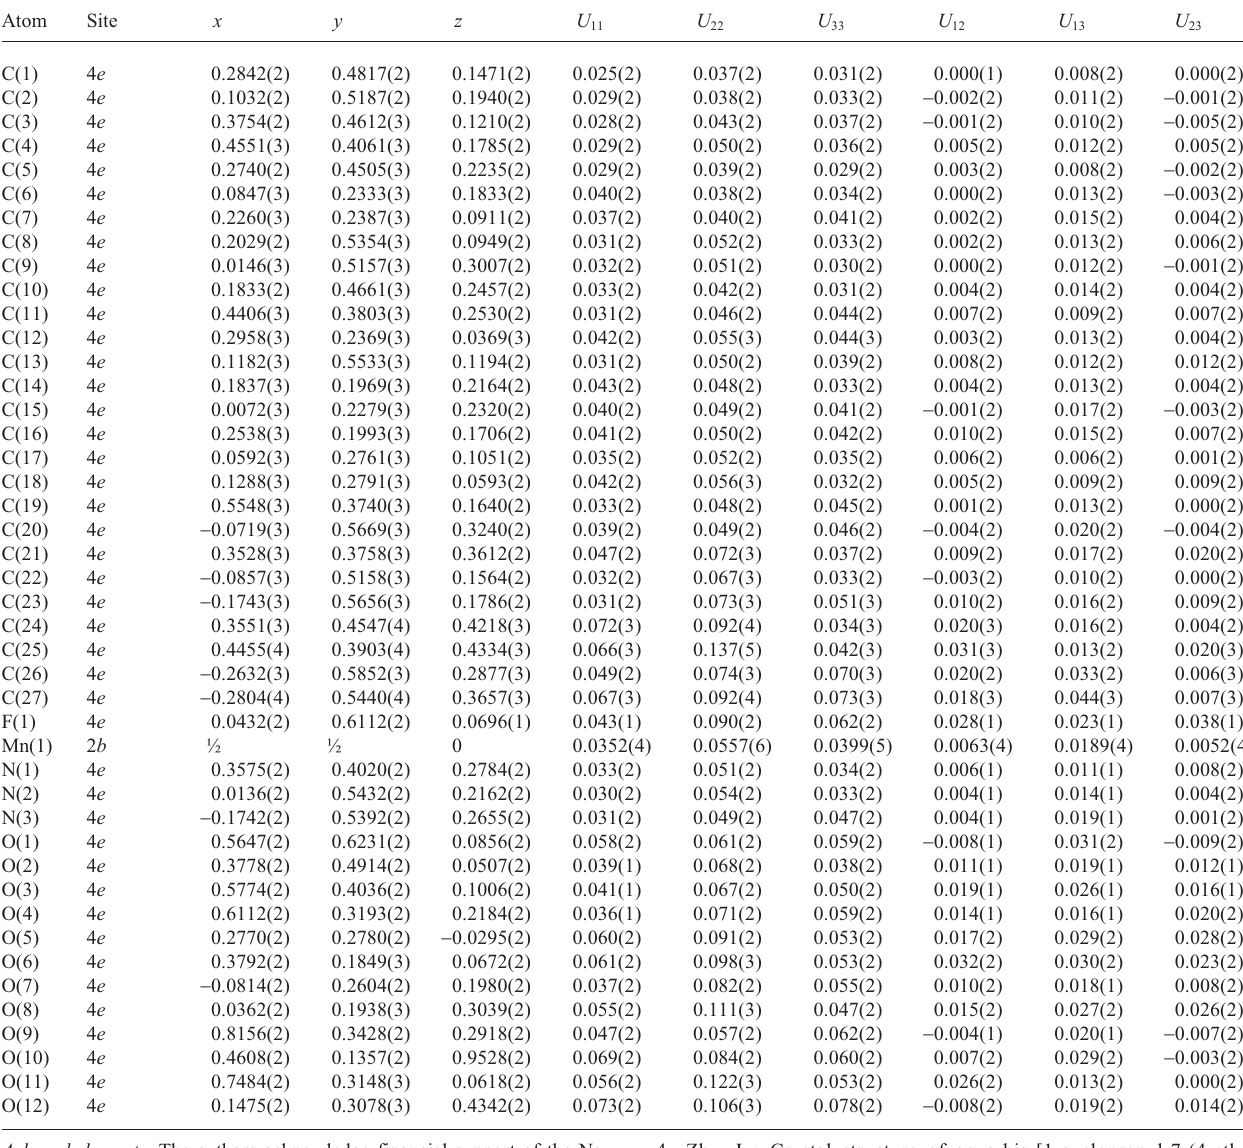
Table 3. Atomic coordinates and displacement parameters (in Å 2 )